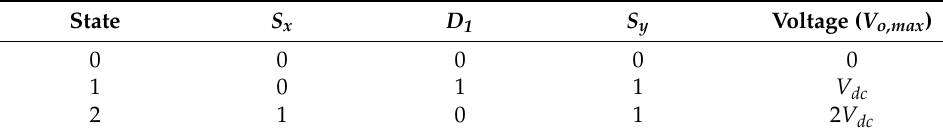
Figure 1. Basic module of proposed converter. Table 1. Switching Sequence of the Proposed Basic